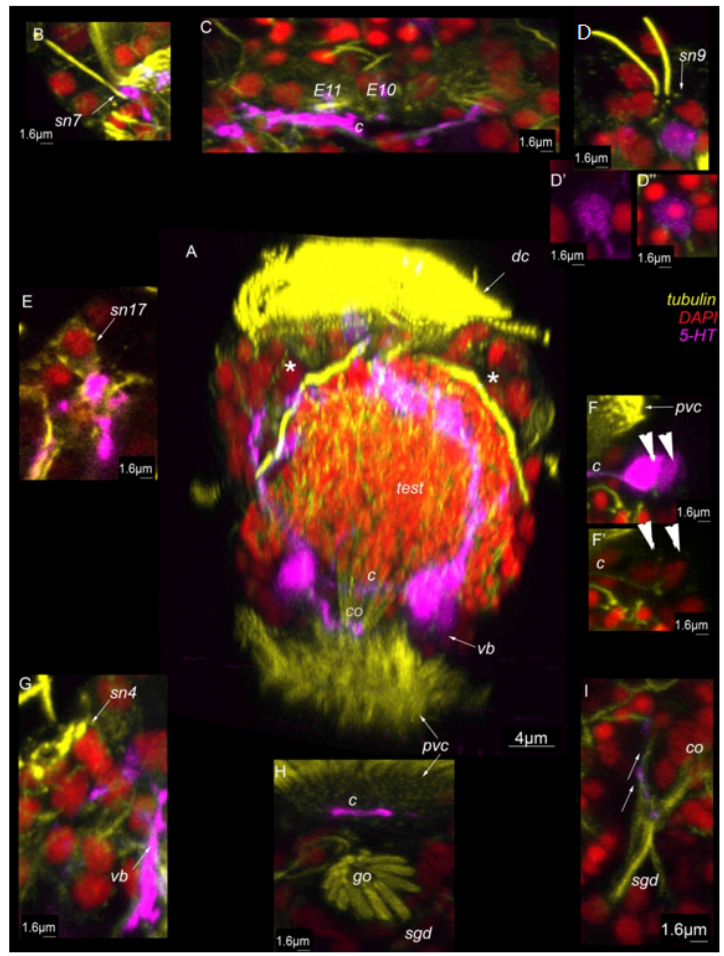
Figure 11. 5-HT-like immunoreactivity in the mature dwarf male of Dimoprhilus gyrociliatus .( A )Ven- tral view on wholemount. ( B ) Sensory neuron № 7 and thin 5-HT-like immunoreactive processes. ( C ) Multiciliated cells of dorsal ciliary field are innervated by 5-HT-like immunoreactive processes. ( D , D’,D" ) Sensory neurons № 9 and unpaired 5-HT-like immunoreactive cell. ( E ) Sensory neuron № 17. ( F, F' ) The cell bodies of 5-HT-like immunoreactive cells. ( G ) Sensory neuron № 4. ( H ) Com- missure. ( I ) 5-HT-like immunoreactive processes innervate copulatory organ. Abbreviations: arrow- heads indicate neuronal cell bodies; avc —anterior ventral cilia; c —commissure; dc —dorsal cilia; test —testis; pvc —posterior cilia; sgd —stylet gland cell; sn1–sn20 —sensory neurons 1–20; sv —semi- nal vesicles; *—nephridia.